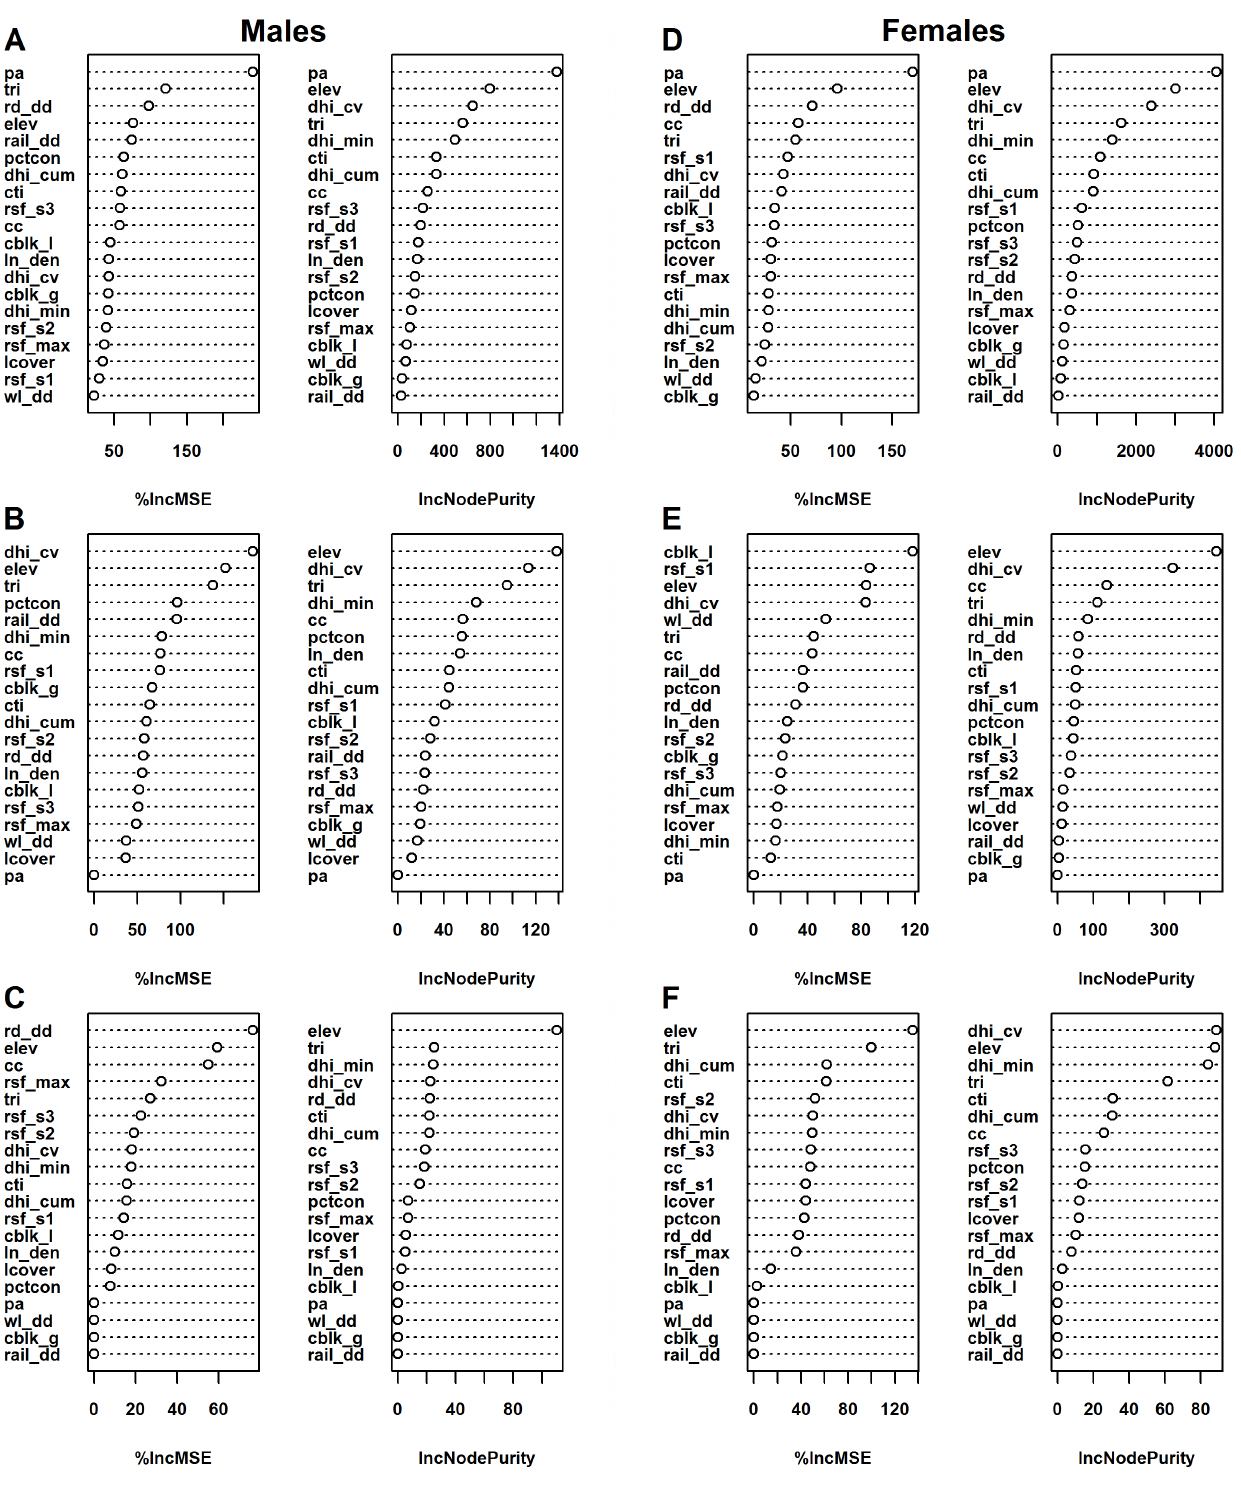
Figure 2. Variable importance metrics for male and female HCC random forest models. Variable importance for the male (A) total model, (B) outside parks and protected areas model, and (C) inside parks and protected areas model, as well as the female (D) total model, (E) outside parks and protected areas model, and (F) inside parks and protected areas model. Variable importance plots on the left of each panel (%IncMSE) represent the accuracy of random forest model predictions based on regression tree splits made using each variable. Plots on the right of each panel (IncNodePurity) indicate how often each variable was used as a split in regression trees aggregated through the random forest. For example, in panels A & D the proportion parks and protected areas was selected often as a tree split in the random forest and had a high predictive HCC value accuracy.